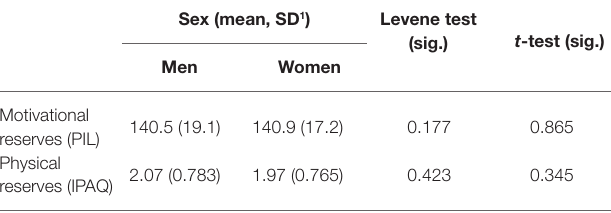
TABLE 1 | Differences by sex in physical and motivational reserves. Sex (mean, SD 1 ) Levene test (sig.) t -test